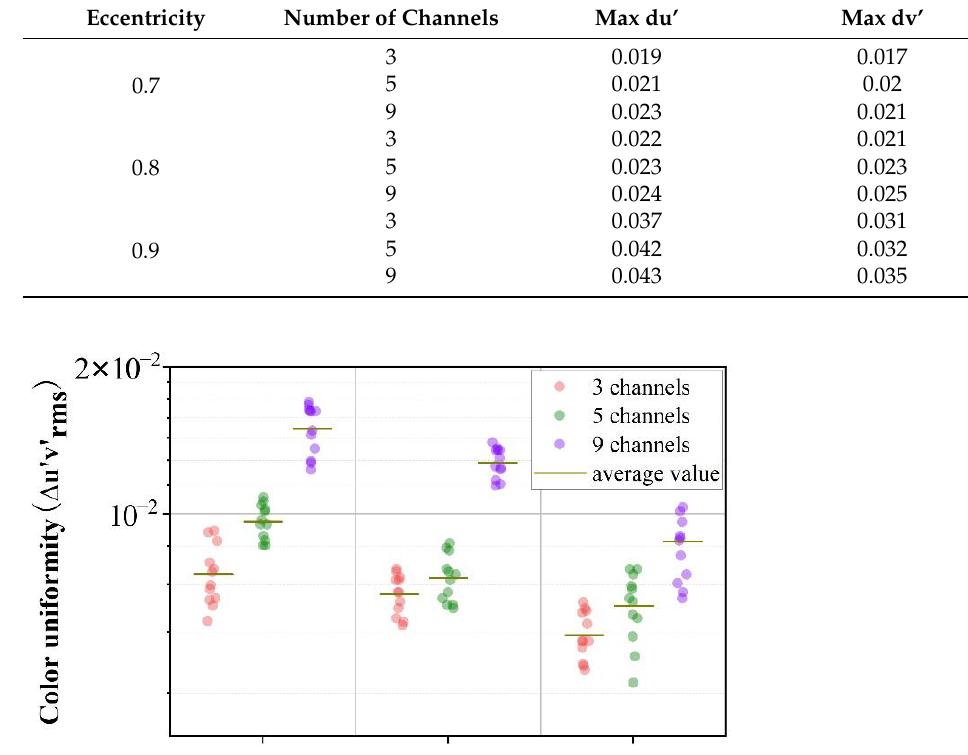
Table 2. The difference of color coordinates.